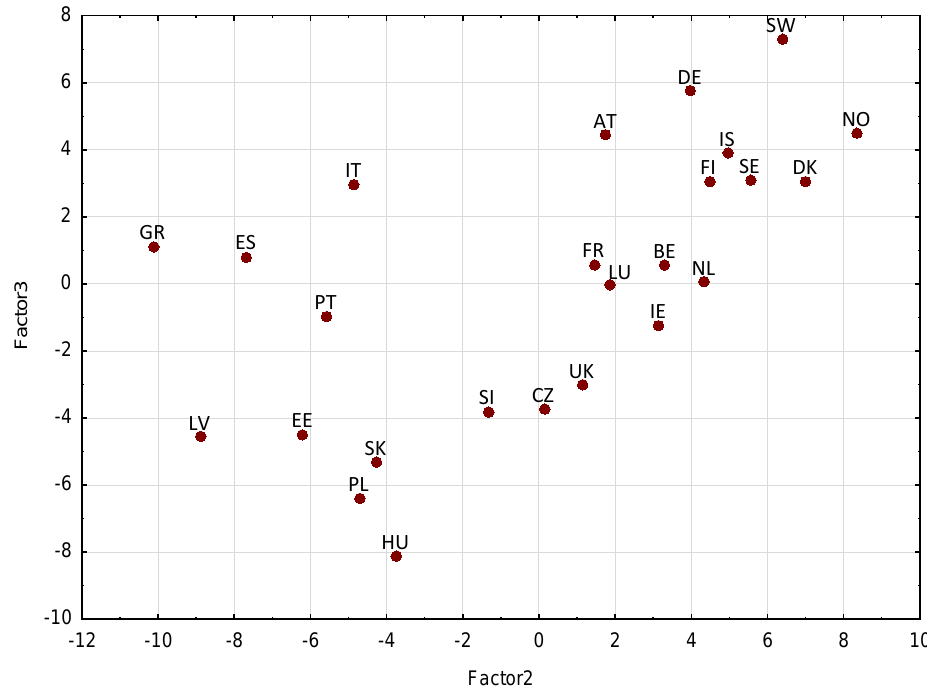
Figure 5. Location of European countries in the coordinate system of the factors F2, F3. Source: self-processed in